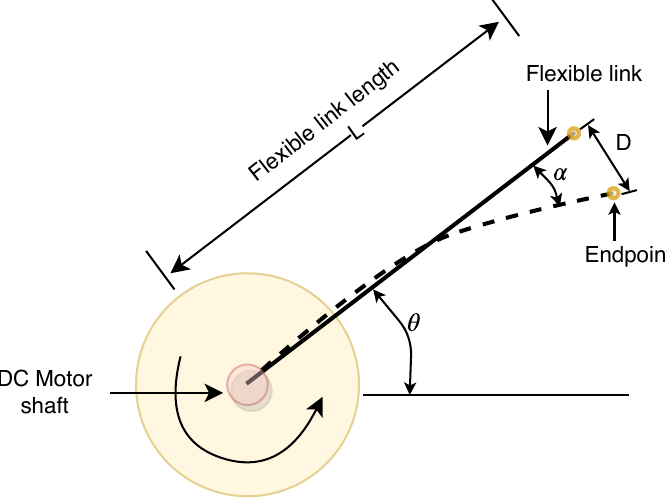
Figure 8. Flexible link manipulator schematic